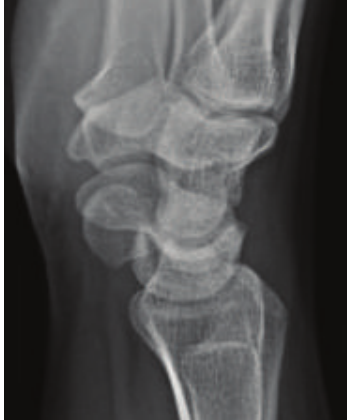
Figure 3: A lateral view of the wrist at the time of initial evaluation without radiographic abnormality of the